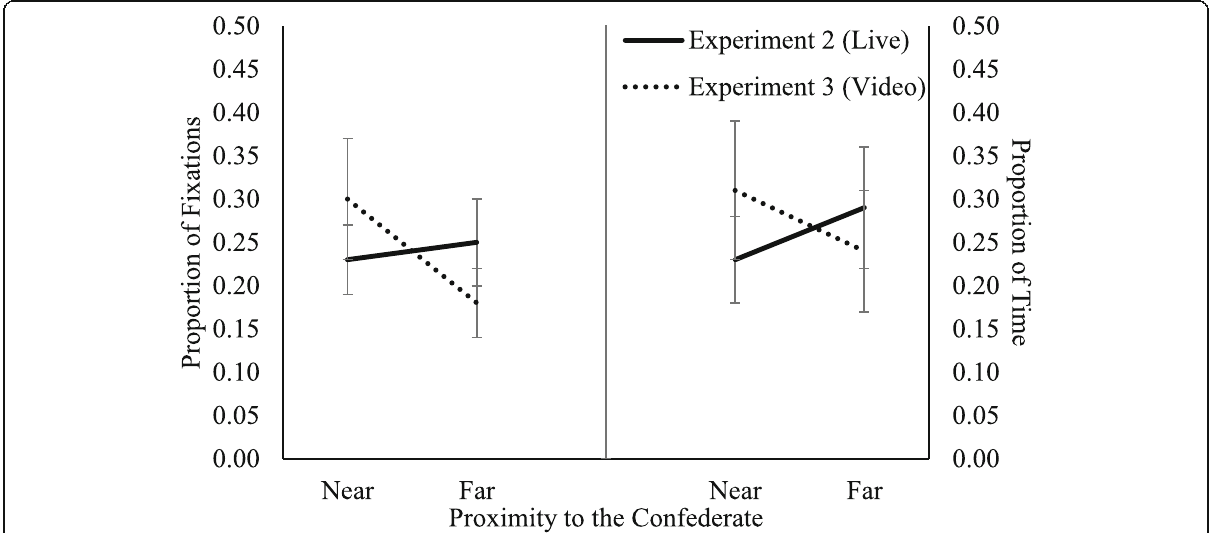
Fig. 5 The mean proportion of fixations (left panel) and time spent on the confederate (right panel) when the confederate was in view for Proximity (near, far) as a function of Experiment (2 and 3). Bars represent 95% confidence